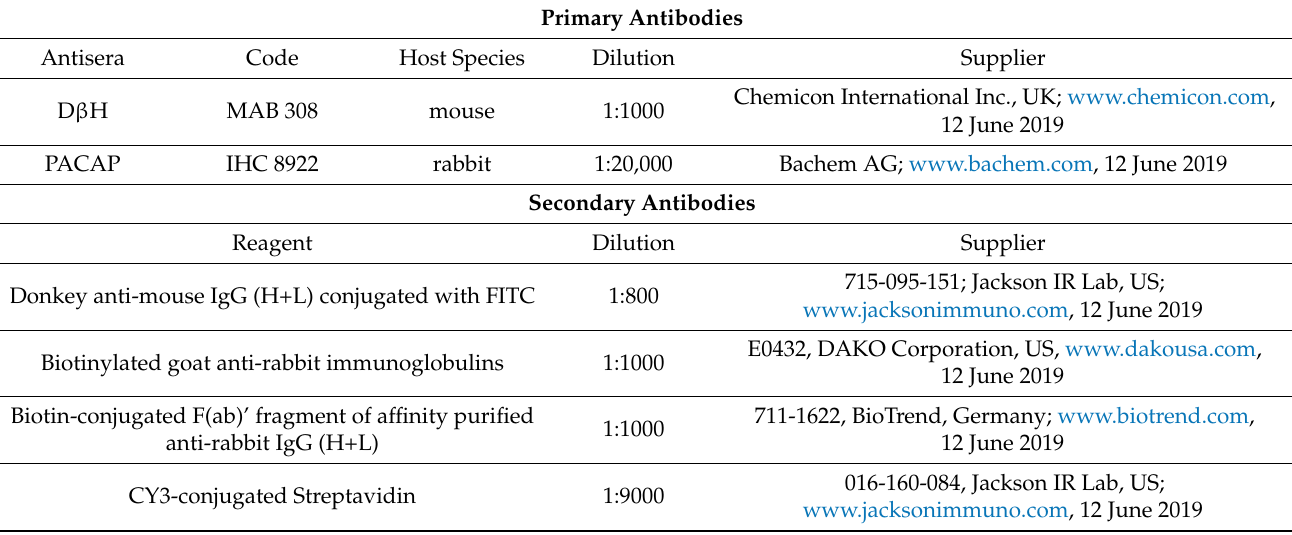
Table 1. Detailed list of primary and secondary antibodies used in the